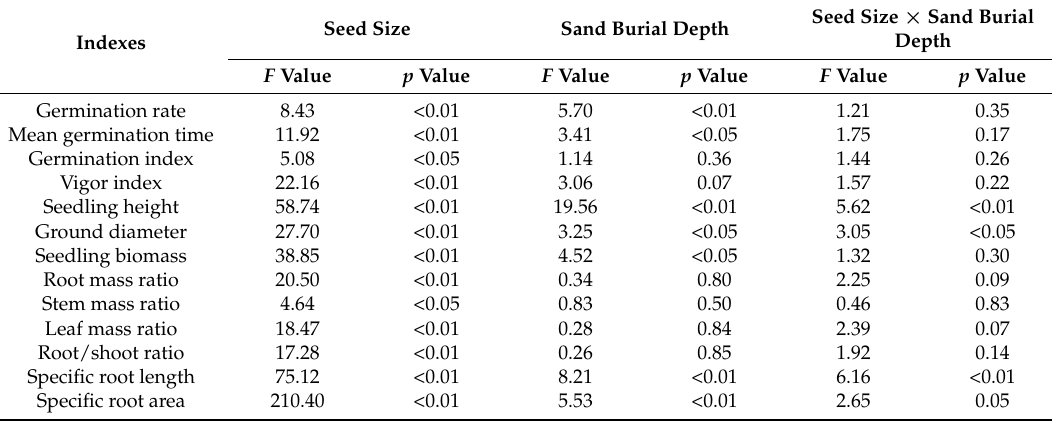
Figure 1. Characteristics of seeds of Pinus thumbergii Parl. in different size groups. ( a ): 1000-seed weight; ( b ): seed maximum length; ( c ): seed maximum width; ( d ): soluble sugar concentration; ( e ): starch concentration. SI: large seeds; SII: medium seeds; SIII: small seeds. Values are means ± standard deviation (SD). Means with different letters are significantly different from each other ( p < 0.05). Table 1. Two-way ANOVA analyses of the effects of seed size, sand burial depth, and their interaction on seed germination and seedling characteristics .